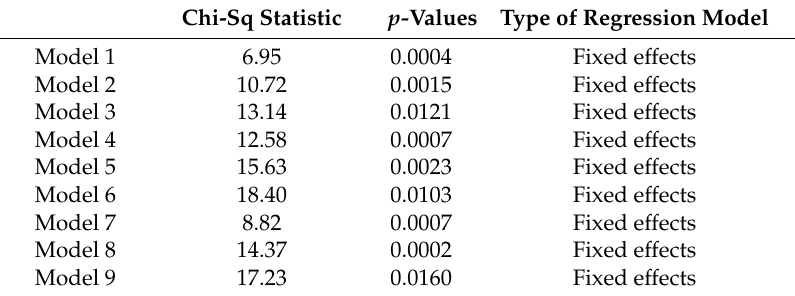
Table 6. Hausman test